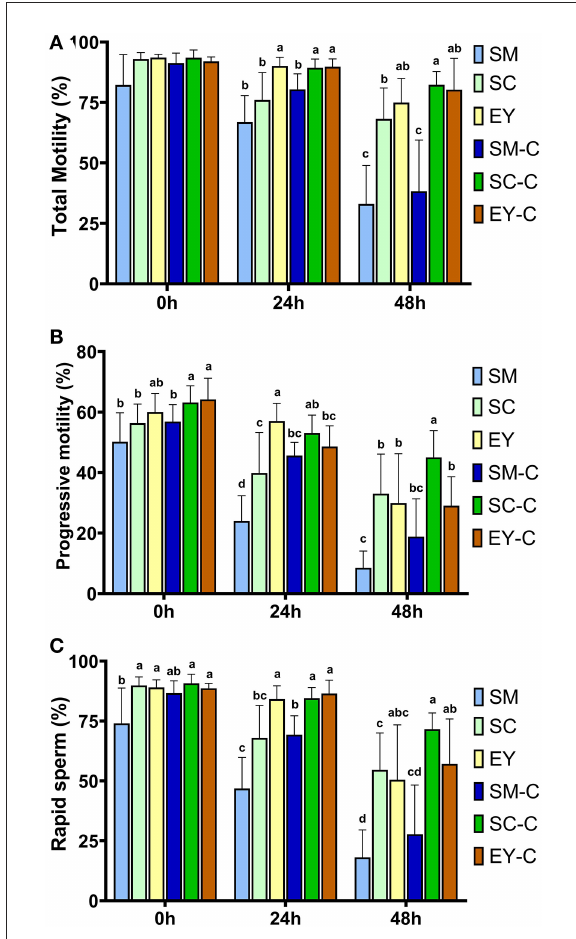
FIGURE1 Sperm kinetics of donkey semen centrifuged (C) or not and extended in skimmed milk (SM), sodium caseinate (SC) or egg yolk (EY) based extender and cooled for 48h. (A) Total sperm motility; (B) Progressive sperm motility; (C) Percentage of sperm with rapid movement. Different superscripts ( a,b,c,d ) denote differences between extenders ( P < 0.05).